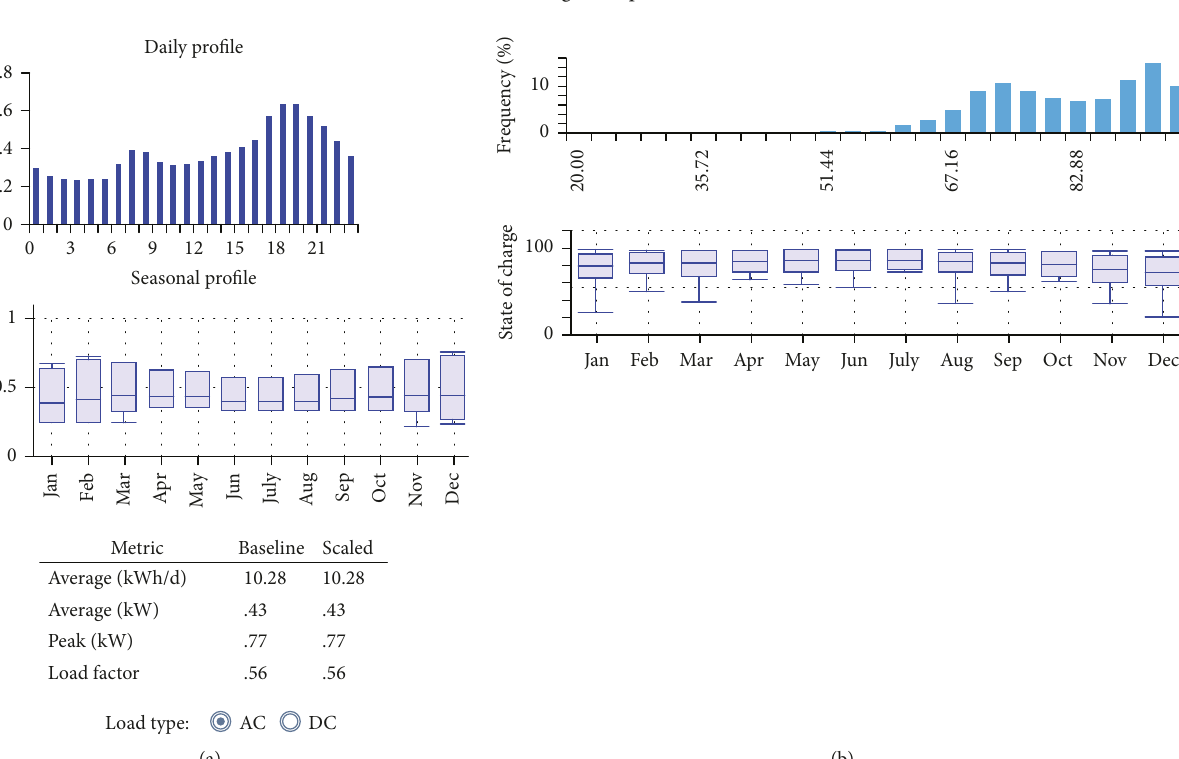
Figure 4: HOMER sizing and optimization results.